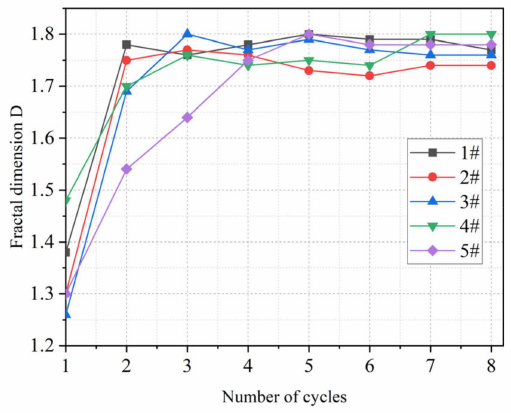
Figure 17. The specimens fractal dimension of disintegrating particles subjected to cycle